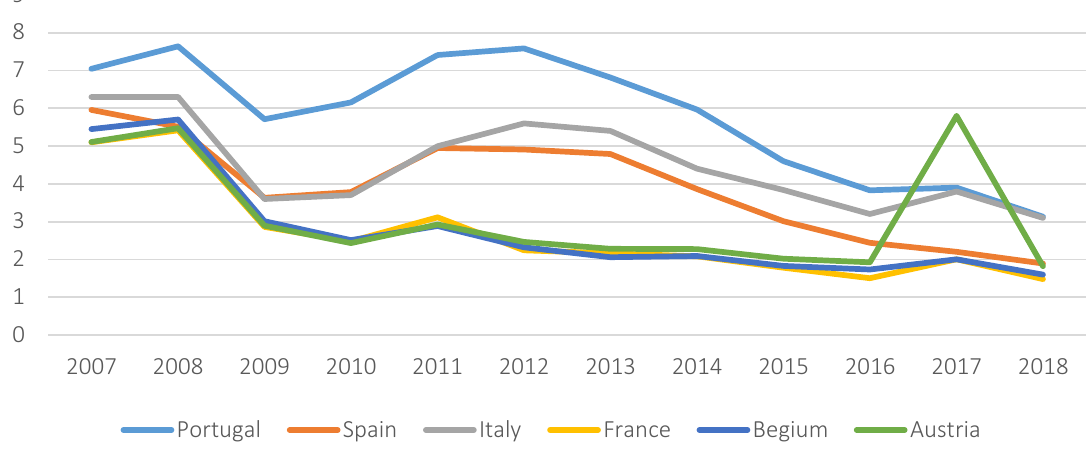
Figure 1. Dynamics of interest rates on loans to SMEs (2007–2018)